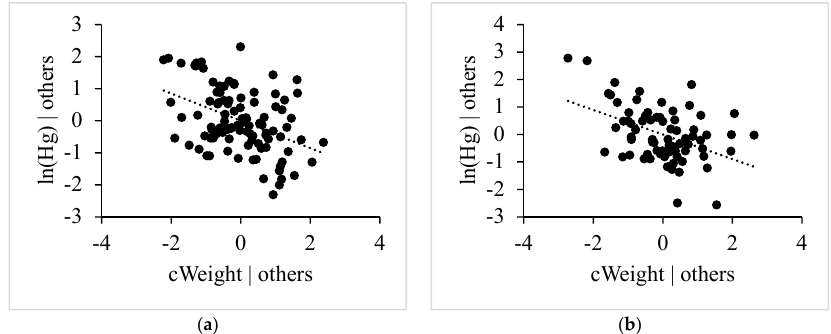
Figure 6. Partial linear regressions using centered, transformed weight as an explanatory variable and logarithmically transformed Tot-Hg-concentration as a response variable. Both variables are corrected for all other explanatory variables in their respective models; ( a ) for E. smelt; ( b ) for whitefish.